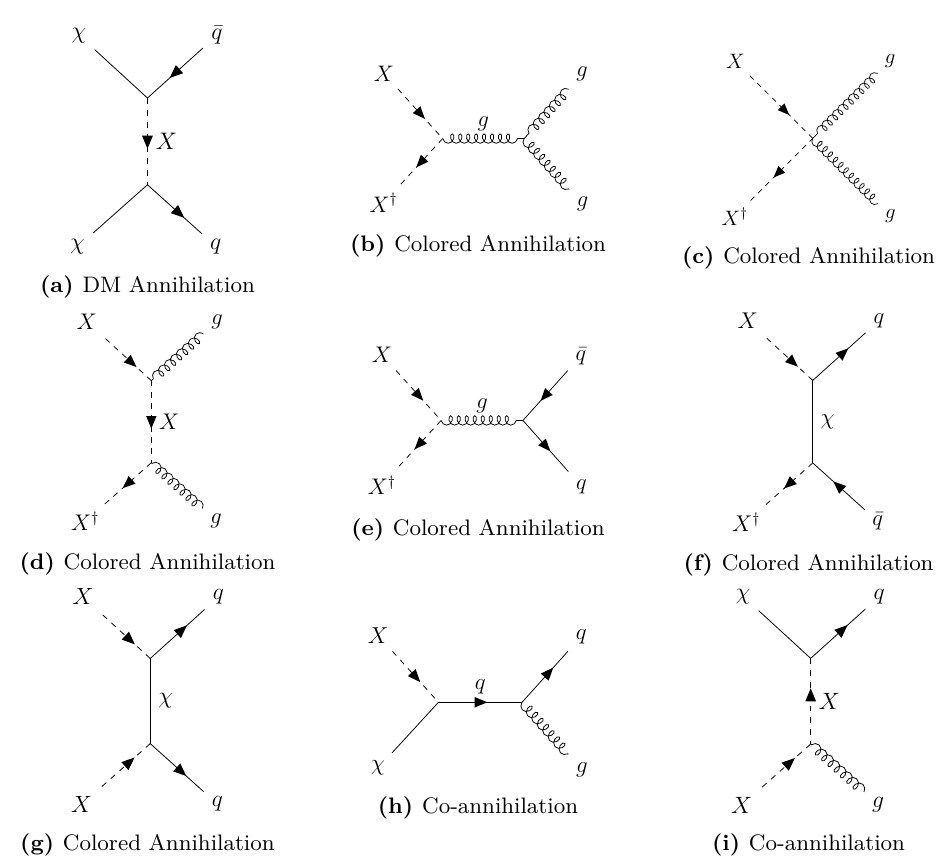
Figure 1: Representative Feynman diagrams corresponding to the main subset of processes contributing to (co-)annihilations described in Tab. ?? . For simplicity, we don’t show here possible interfering diagrams from crossing symmetries (for example, we would have an u -channel for χχ → q ¯ q , XX † → q ¯ q and XX → qq ). We also only illustrated the gluon gauge vertices, since the strong coupling dominates. In diagram 1h, we could also have the interaction of any other SM gauge boson with the quarks, while in diagrams 1b, 1c, 1d, 1e and 1i, the gluon can be replaced by a photon or a Z boson in the u R and d R models and additionally by W ± bosons in the q L model.